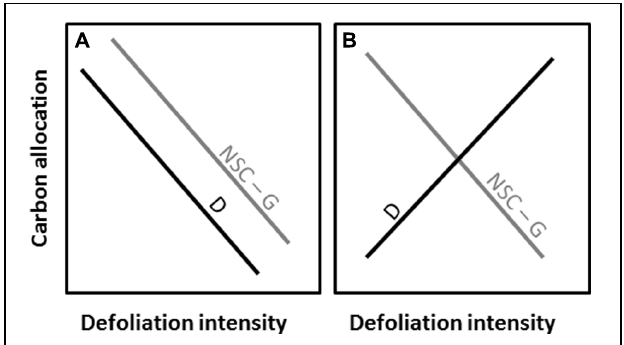
FIGURE 1 | Theoretical patterns of carbon allocation to defense (D), non-structural carbon (NSC) and structural growth (G) with increasing defoliation intensity. The patterns are illustrated with the absence (A) or presence (B) of trade-off between the carbon